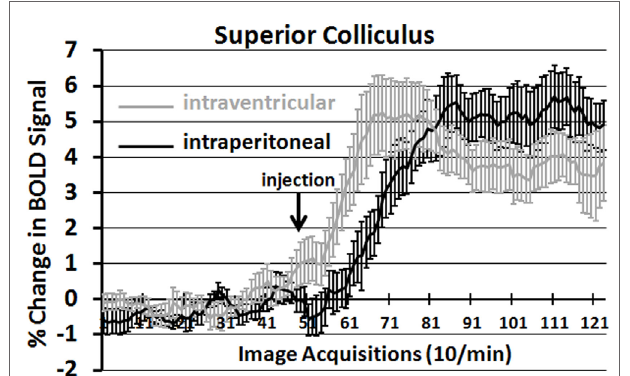
FigUre 3 | Onset of BOlD signal change: intracerebroventricular versus intraperitoneal oxytocin . Shown are the time-course plots for the change in BOLD signal in the superior colliculus following injection (arrow) of OT into the lateral cerebroventricle (gray, n = 8) or peritoneal cavity (black n =